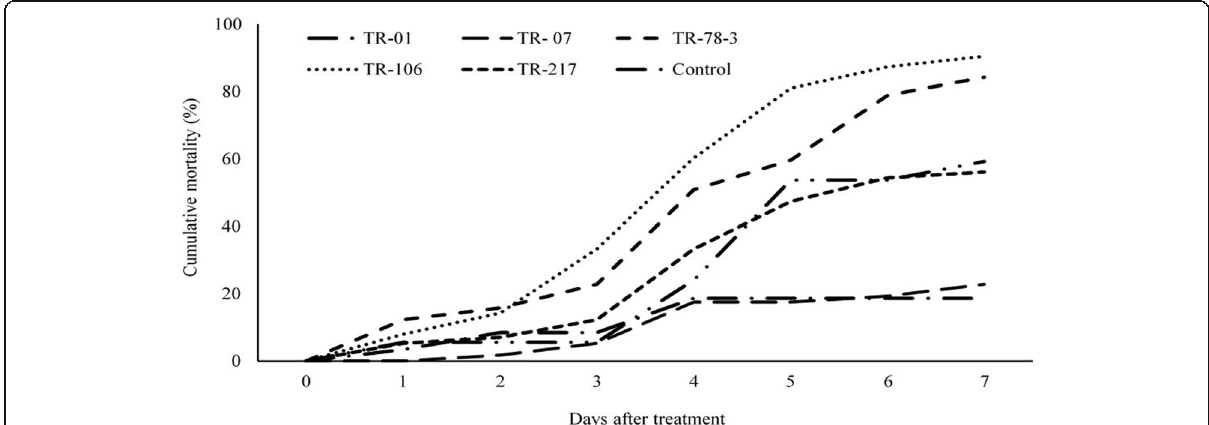
Fig. 2 Mortality rate of Sitophilus oryzae treated with entomopathogenic fungi at 25 °C